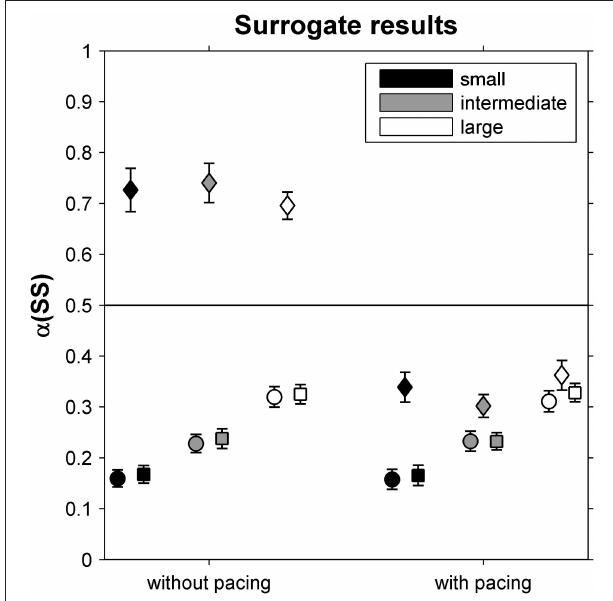
FIGURE 3 | DFA scaling exponents α (SS) for original stride-speed time series (circles) as well as for phase-randomized surrogates (diamonds) and cross-correlated phase-randomized surrogates (squares), depicted as a function of Pacing and Walking Area conditions. Error bars represent standard